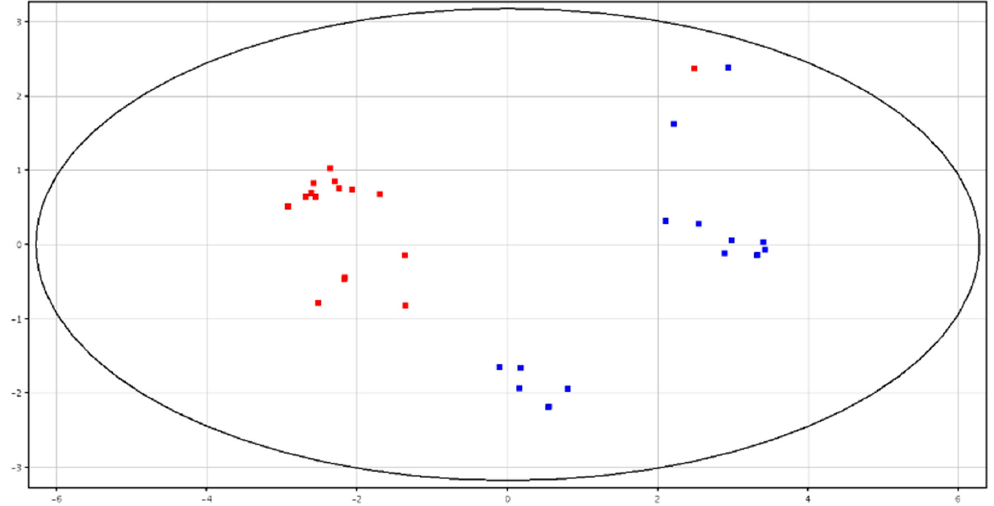
Figure 6. PCA scores plots of the LC–MS data acquired from cryopreserved spermatozoa for high (in red; HF) and low (in blue; LF) fertility bulls. PC1 ( x -axis) is 59.92%; PC2 ( y -axis) is 15.38%.